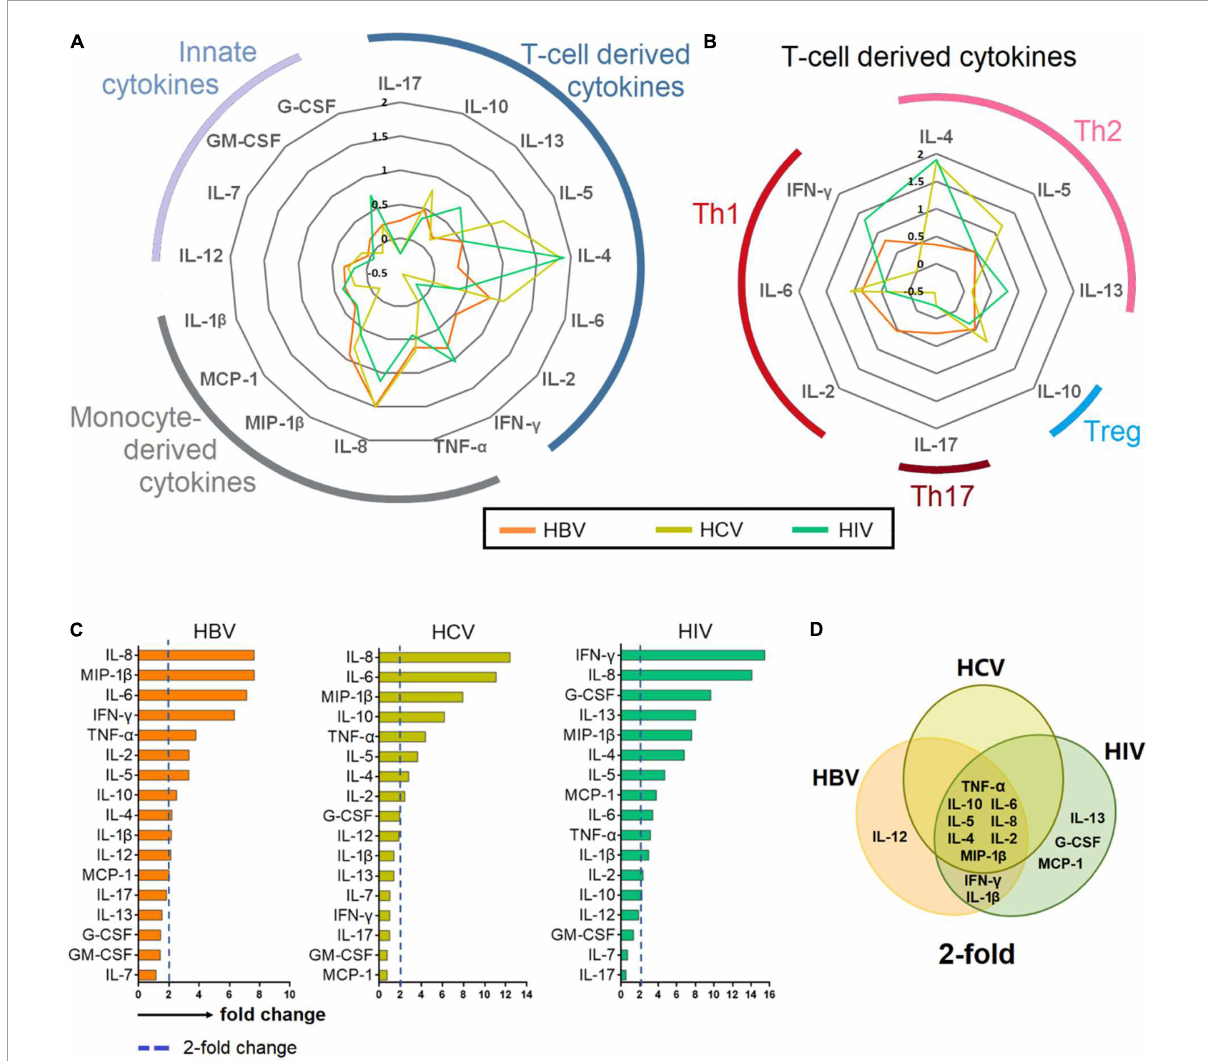
FIGURE3 Cytokine profiling in chronic hepatitis B virus (HBV), hepatitis C virus (HCV), and human immunodeficiency virus (HIV) infections. (A–B) Cytokines with a > 2-fold change in patients chronically infected with HBV, HCV and HIV normalized against HCs. (C) Bar plot showing mean 2-fold change among all cytokines ranked in descending order. (D) Venn diagram depicting cytokines that are upregulated > 2-fold. The Venn diagram identified 8 cytokines that are common among patients chronically infected with HBV, HCV and HIV.